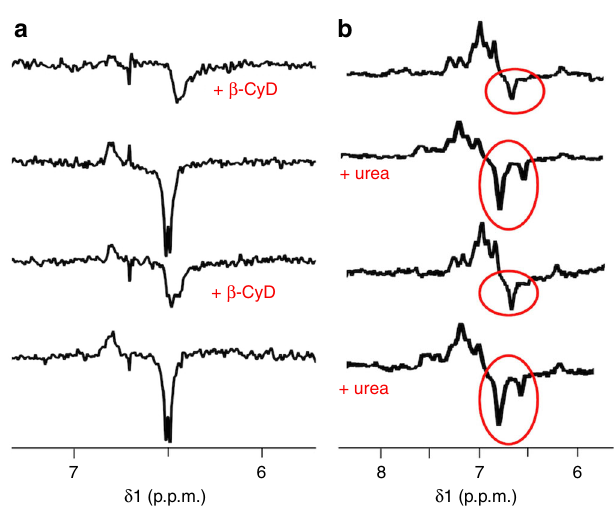
Fig. 5 Ef fi cient mixing on microcoils for sophisticated photo-CIDNP applications. a An experiment to promote solvent burial of a polarizable molecule. Mixing of 10 mM AcTyr and 2 mM FMN (through a syringe, ‘ 1 ’ ) with 30 mM β -cyclodextrin ( β -CyD) (using another syringe, ‘ 2 ’ ), results in a mixture of 5 mM AcTyr, 1 mM FMN and 15 mM β -CyD in the detection region in which the amino acid becomes encapsulated. Its lower solvent exposure (and therefore accessibility to FMN), causes the AcTyr signal to broaden and shift (see also Supplementary Figure 3). b An experiment to promote solvent exposure of a polarizable molecule. Mixing of 4 mM LytA 239 – 252 and 2 mM FMN (syringe 1) with 9 M urea (syringe 2), results in a mixture of 2 mM LytA 239 – 252 , 1 mM FMN and 4.5 M urea in the detection region in which LytA 239 – 252 loses the native structure and the two tyrosines become solvent exposed. The higher accessibility to FMN yields two signals corresponding to the H ε protons of two distinct tyrosines show up in the spectra. Note the highly reproducible pattern in both cases when the mixing is turned on and